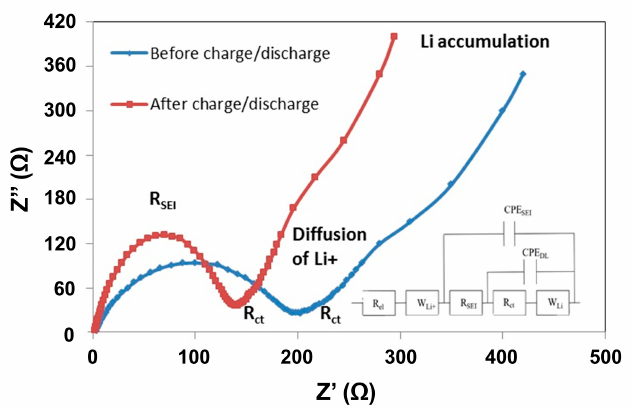
/ discharge. Crystals 2020 , 10 , x FOR PEER REVIEW